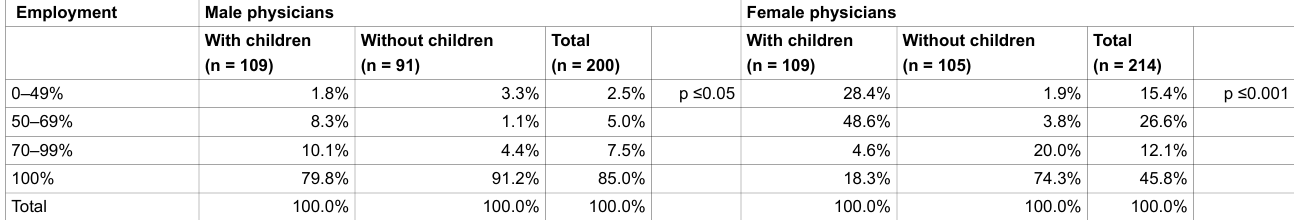
Table 2: Employment status of male and female physicians with and without children (N = 414).